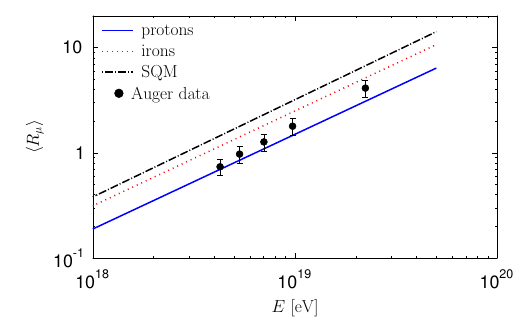
R µ of individual showers gen- (cid:31) (cid:30)